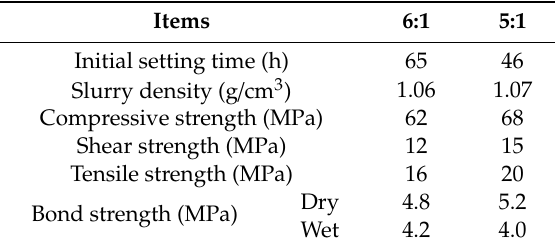
Table 1. Physical and mechanical properties of CW epoxy grouting